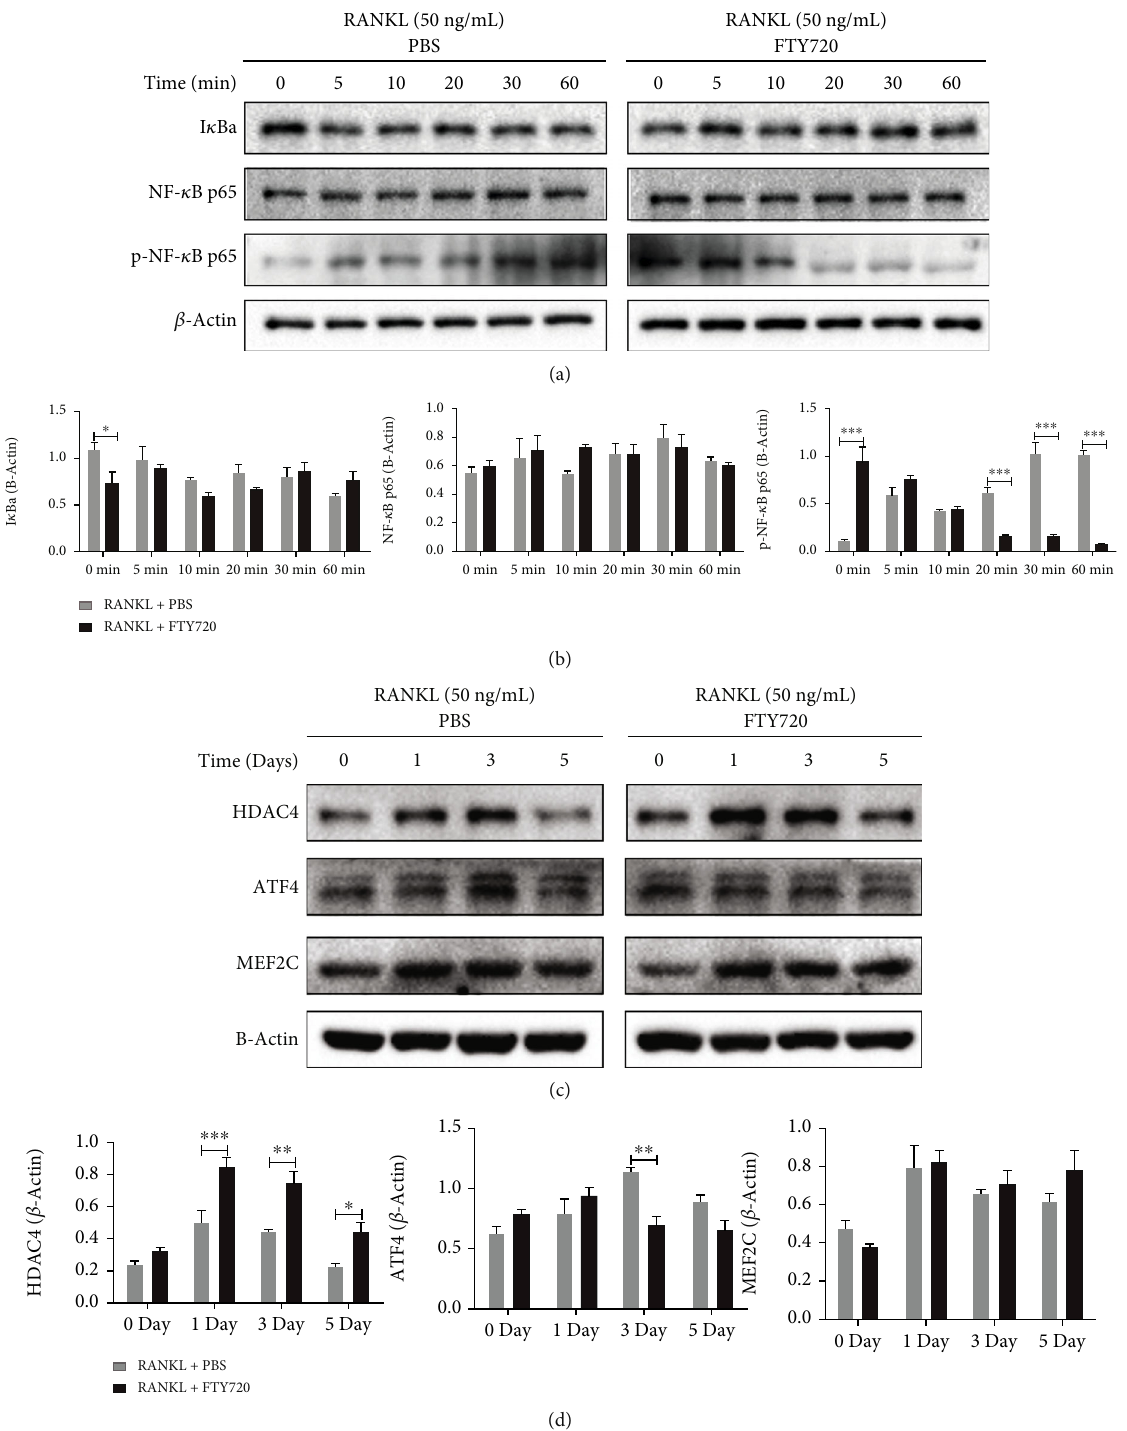
Figure 3: FTY720 suppresses the nuclear factor kappa-B (NF- κ B) signaling pathway and upregulates histone deacetylase 4 (HDAC4) expression. (a) Western blotting of I κ B α , NF- κ B p65, and p-NF- κ B p65 expression at 0, 5, 10,20, 30, and 60 min under RANKL (50